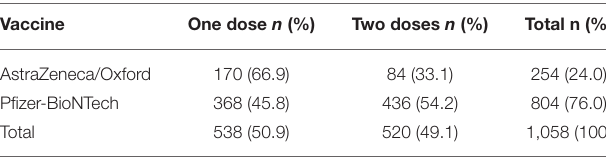
TABLE 3 | Classification of participants based on types of COVID-19 vaccine